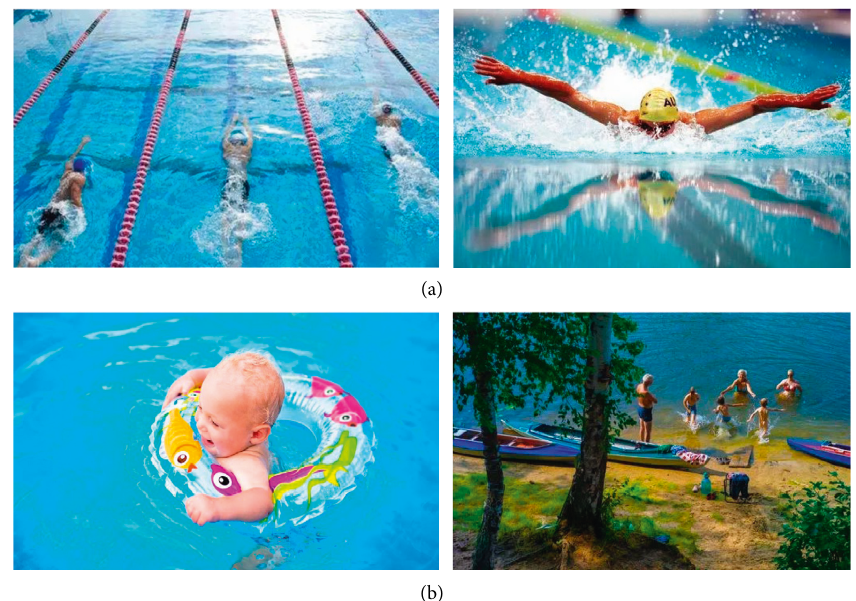
Figure 1: Types of swimming exercises: (a) competitive swimming and (b) recreational